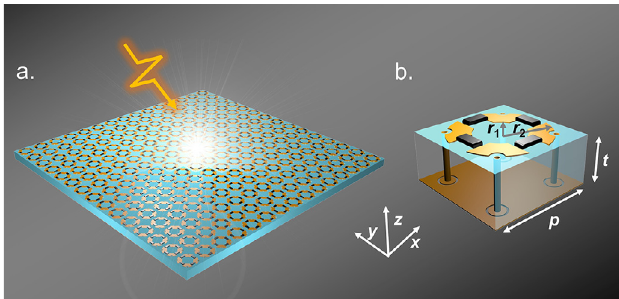
Fig. 1. (a) Schematic of the proposed metamaterial absorber, which can ef fi ciently absorb the incident wave in a broad frequency band. (b) Details of the unit cell con fi guration. Four metallic via holes are embedded into the dielectric substrate and connected to the metallic circular patches that are isolated from the ground with a gap width of 0.1 mm. The via hole has a radius of 0.15 mm, while the patch has a radius of 0.4mm. Four semicircular corners are cut from the metallic ring structure on the